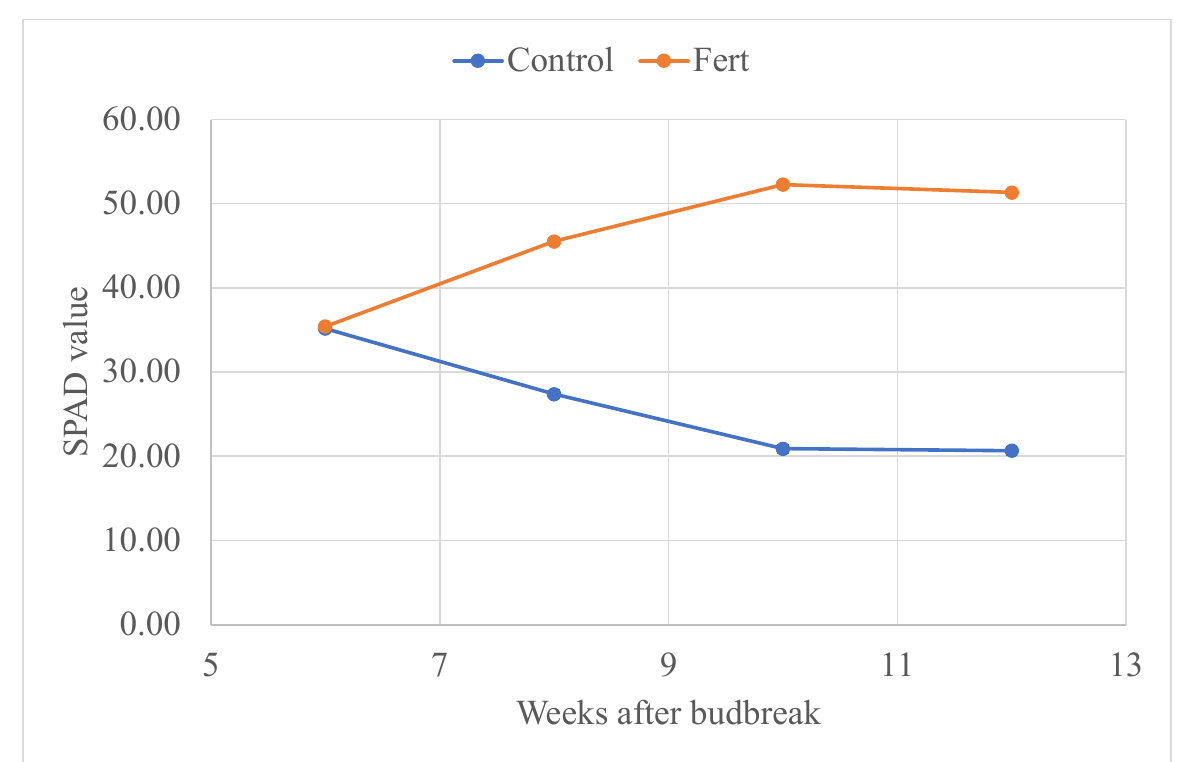
Figure 2. Mean values ( ± standard error) of four SPAD measurements of shrub willow genotypes in a greenhouse trial for fertilized treatment (red) and water control (blue).